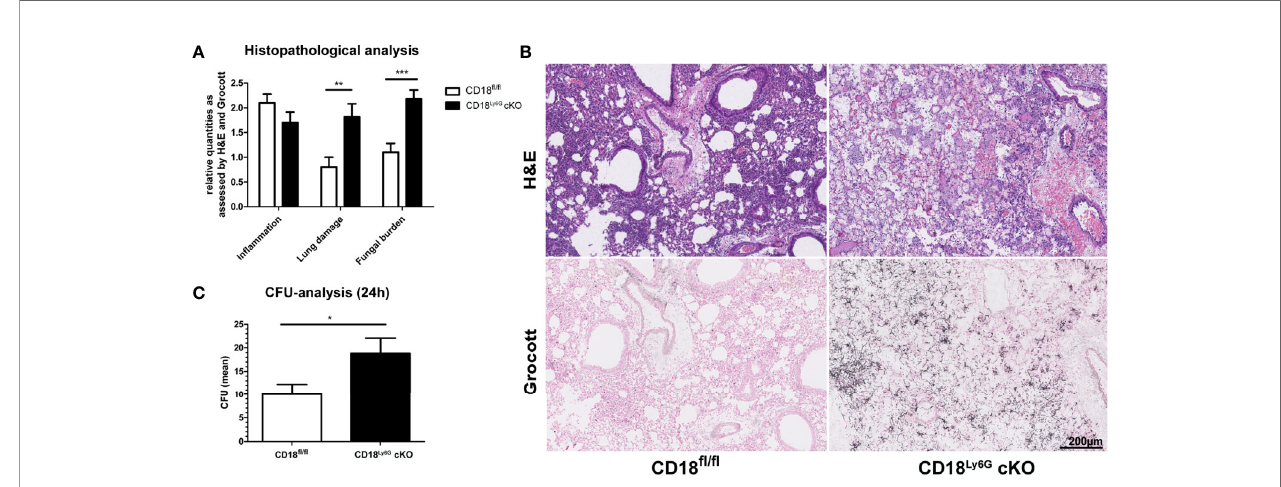
FIGURE 3 | CD18 Ly6G cKO mice show a higher pulmonary fungal burden. Histopathological analysis of H&E and Grocott-stained lungs derived from IPA-infected mice 24h upon A.fumigatus inoculation revealed a higher fungal burden and a stronger lung damage (i.e., hyaline membranes, fi brin-exudate within the alveoli) in CD18 Ly6G cKO mice (A) . Cellular in fl ammation did not show signi fi cant genotype-dependent differences. Representative examples of histological analysis are shown in (B) (Magni fi cation 10x). Data in (A) denote results of histopathological analysis of n=9-10 mice/genotype. We further observed higher CFU counts in serial dilutions of lung homogenates (1:500) after incubation for 24h on Sabouraud-4% Glucose agar plates (C) . Data show the mean ± SEM of 6 mice/group. Statistically signi fi cant differences between groups are indicated (*p<0.05, **p<0.005, ***p<0.001).